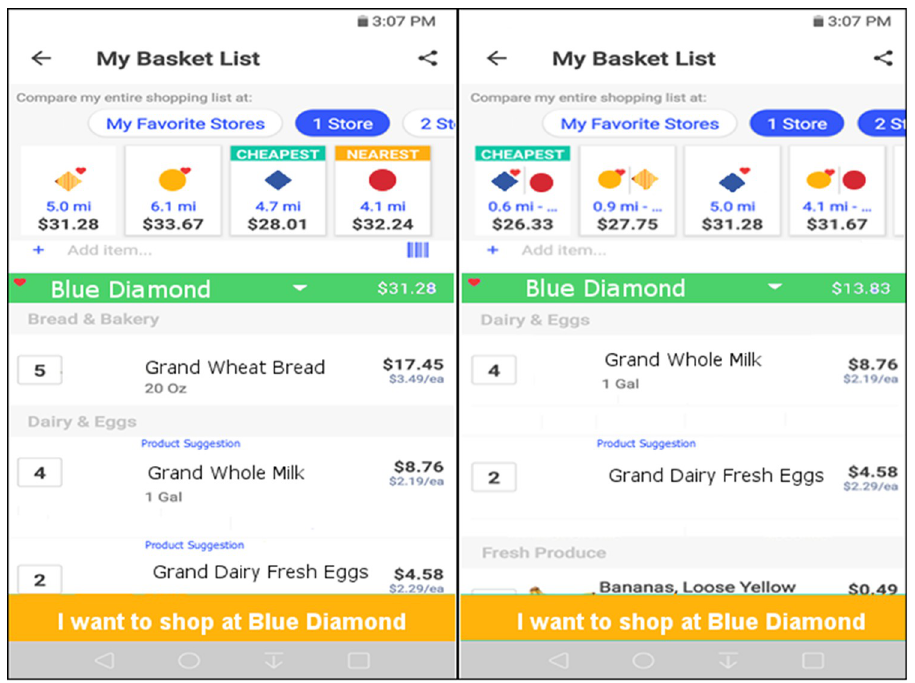
Fig 1. Screenshots from a representative application illustrating the effect on total cost by going to one store (left hand side) or two stores (right hand side) to complete the purchase of a basket of items. Total cost is lowered from $28.01 to $26.33 if the user chooses the cheapest two-store